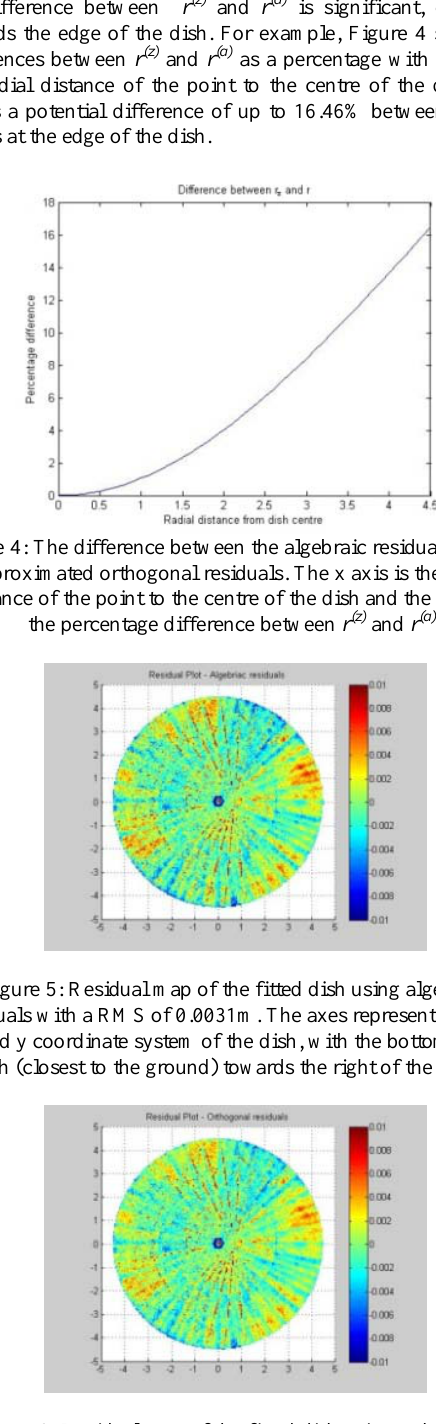
Figure 6: Residual map of the fitted dish using orthogonal residuals with a RMS of 0.0028m